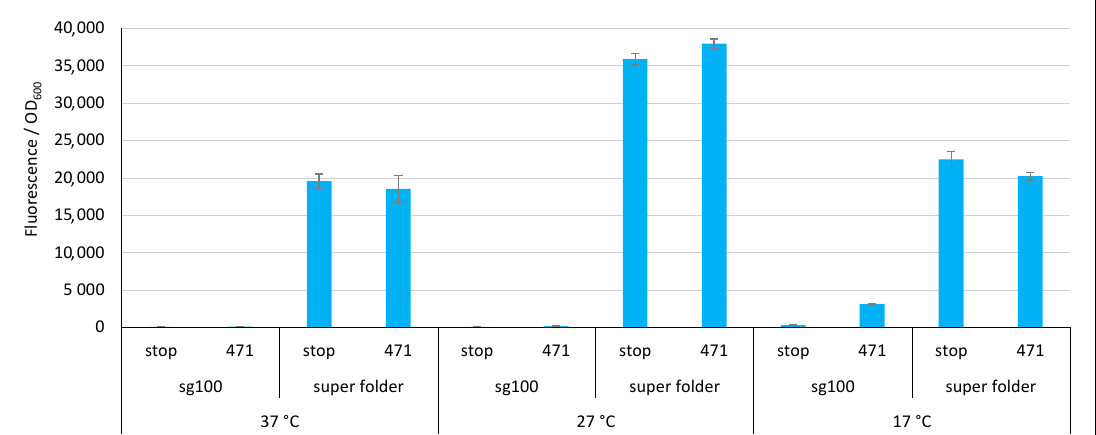
Figure 6. Comparison of sg100 and sf GFP variants. Fluorescence to OD 600 ratios of a split-GFP reassembly assay as obtained with the negative (stop) and positive (471) controls of the 471/XD interaction with sg100 and sf GFP reporters at 37 ◦ C, 27 ◦ C and 17 ◦ C.